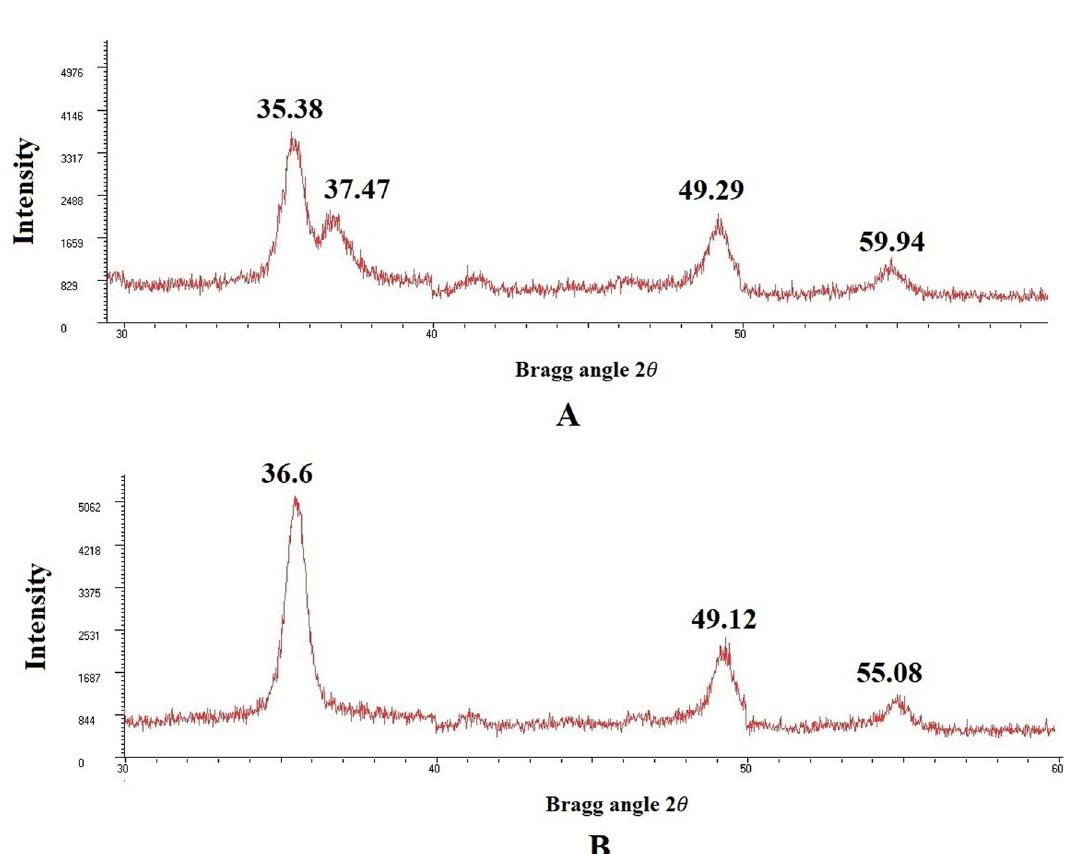
Figure 10. X-ray diffractometer analysis. ( A ) Diffraction pattern of CCNP at 2θ . ( B ) Diffraction pattern of mAbCCNP at 2θ